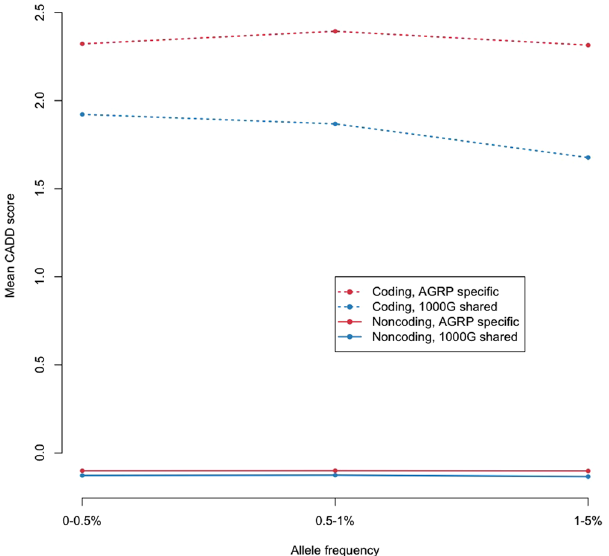
Figure 1. Variants seen only in AGRP are more deleterious. Mean Combined Annotation Dependent Depletion (CADD) scores for AGRP-specific variants (red) and those shared with the 1000G sample (blue), annotated as non-coding (solid lines) or coding (dotted lines), and binned by minor allele frequency.